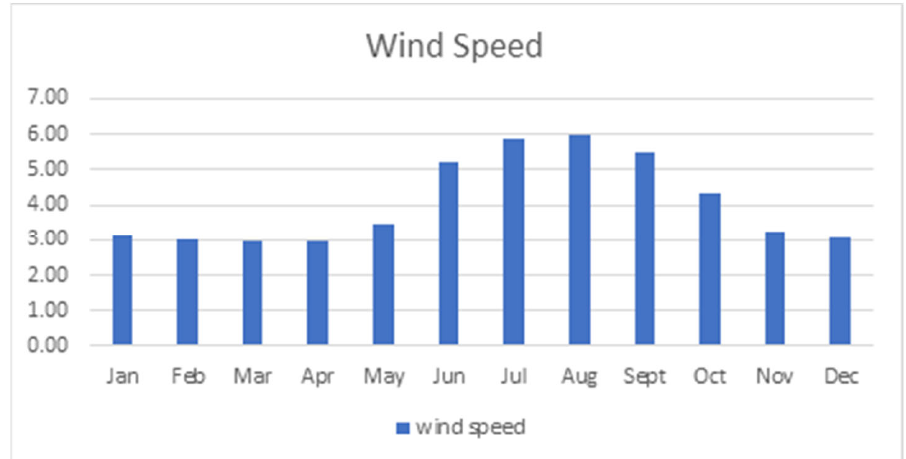
Figure 3. Wind speed at an altitude of 100 m.